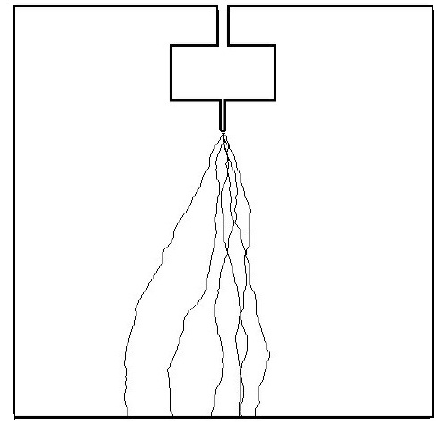
Figure 4: Simulated concrete crack trajectories for d=1.1 and D=0.05